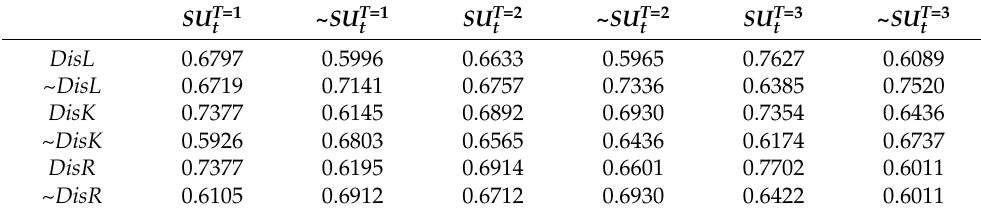
Table 4. Necessity Analysis Table (Industrial Structure Upgrading Indicators).